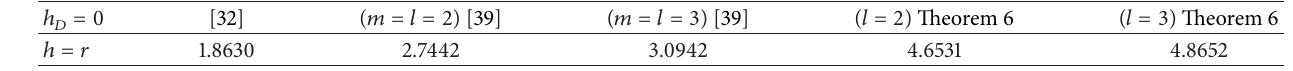
Table 1: Maximum allowable time-delay bounds ℎ = 𝑟 in Example 1.